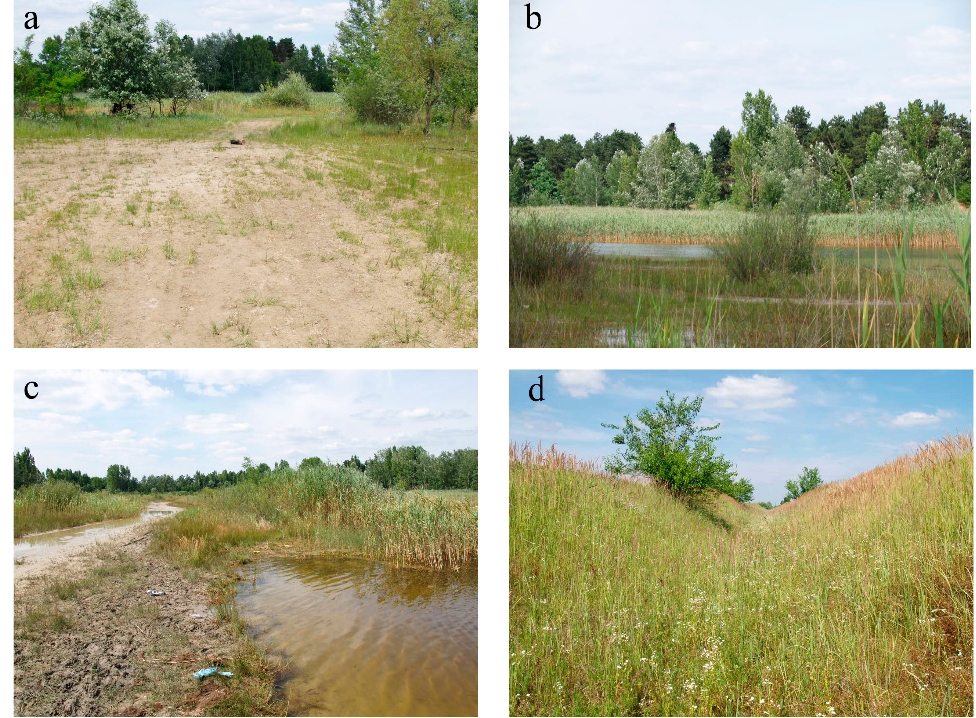
Figure 7. Localities where hexaploid plants characterized as C. pannonicum were found. ( a ), ( b ), and ( c )—Majdan ( MJ ); ( d )—Pali ć ( PA ).